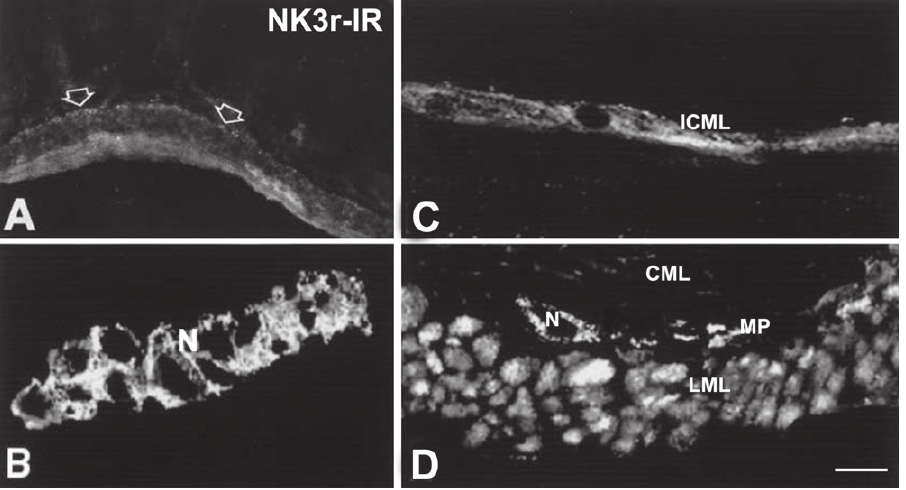
Figure 4 Mouse and guinea pig ileum NK3r-IR.